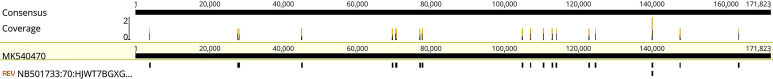
Mapping results of EBV reads in cerebrospinal fluid (CSF). Mapping results of EBVs in the CSF to EBV reference genome MK540470.